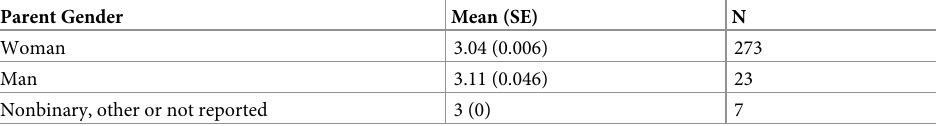
Table 8. Parent stereotype endorsement: Means, standard errors, and N’s by parent gender.